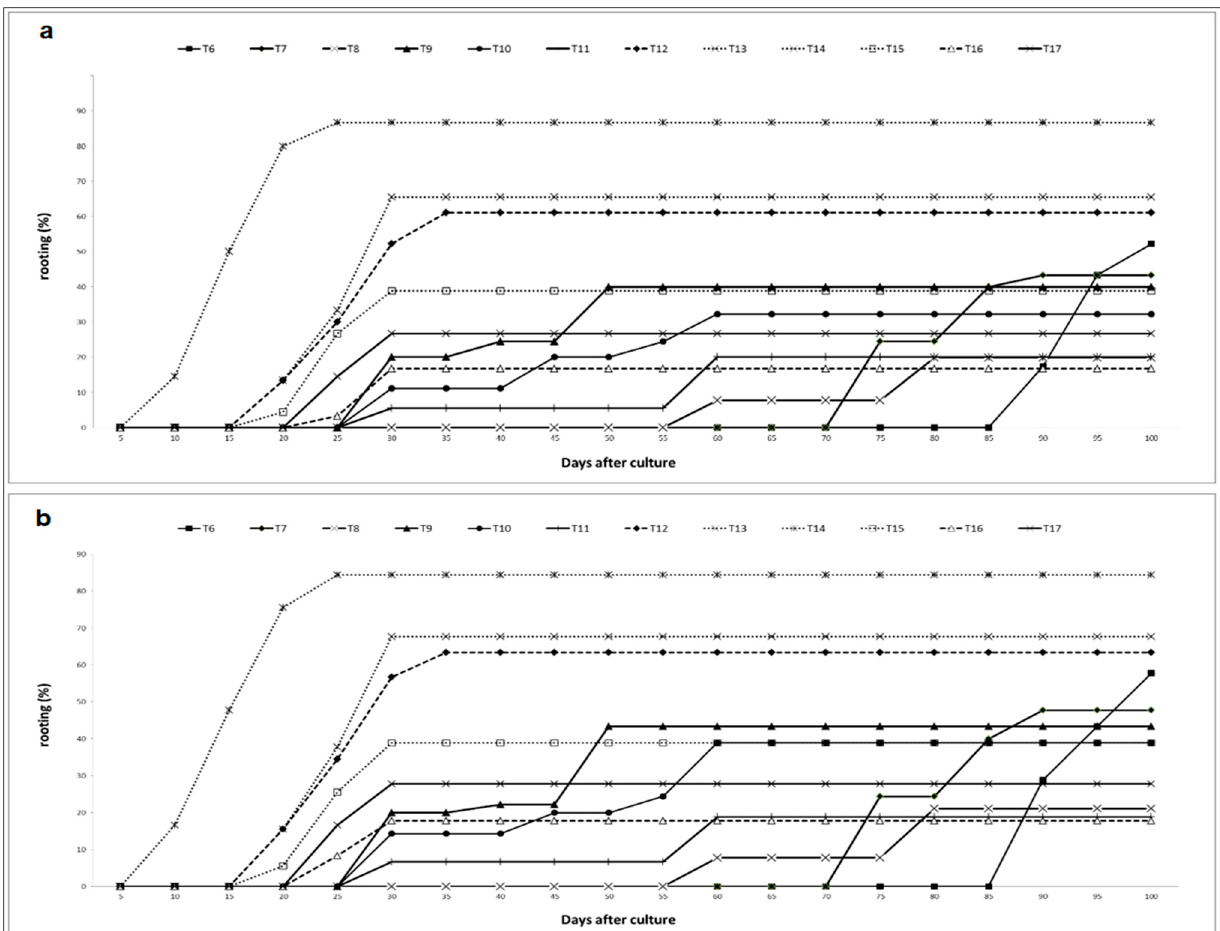
Figure 1. In vitro rooting kinetic of the two genotypes of Argania Spinosa in different culture media mentioned in Table 1. ( a ) genotype “Mejji”; ( b ) genotype “R’zwa”.